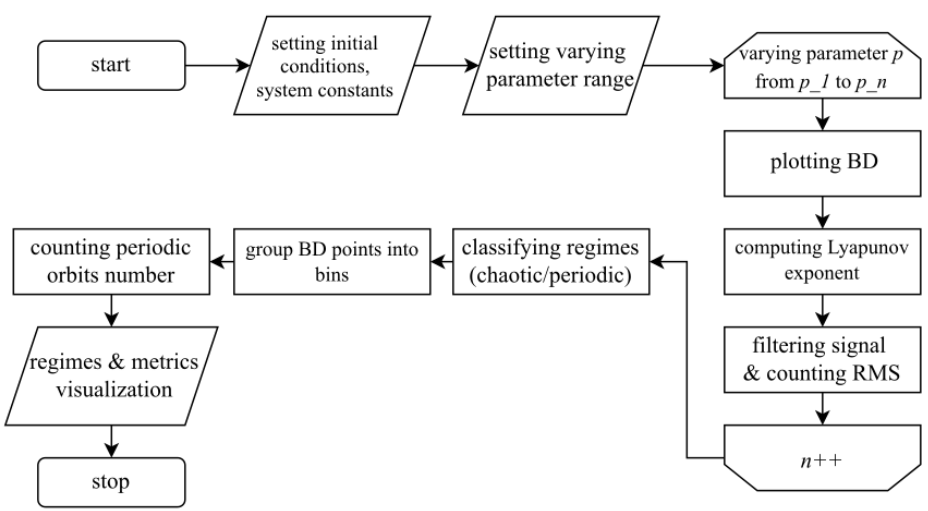
Figure 1. The block diagram of an algorithm for oscillator sensitive modes searching. The results of the algorithm application are given in Section 3.1.